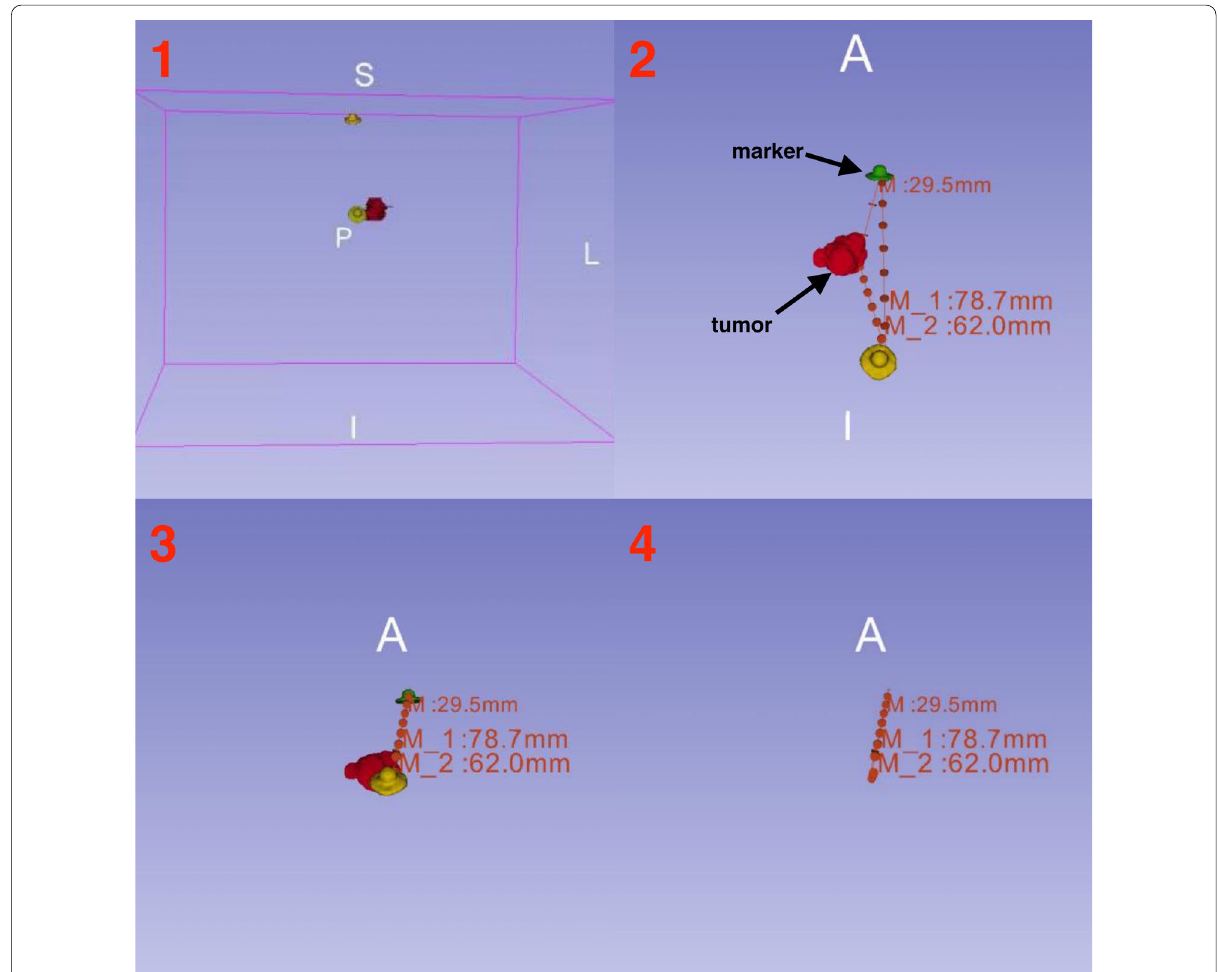
Fig. 3 ( 1 ) Through the reconstruction function of the software, the spatial relationship between tumor and markers can be observed. ( 2 ) The measurement tool measures the distance between the three models. ( 3 ) By rotating the model angle, make sure that the three-line segments are in the same plane. ( 4 ) After closing the model, it is more convenient to confirm whether the three-line segments are in the same plane, and each two line segments intersect at one point. A anterior, P posterior, S superior, I inferior, L left, R